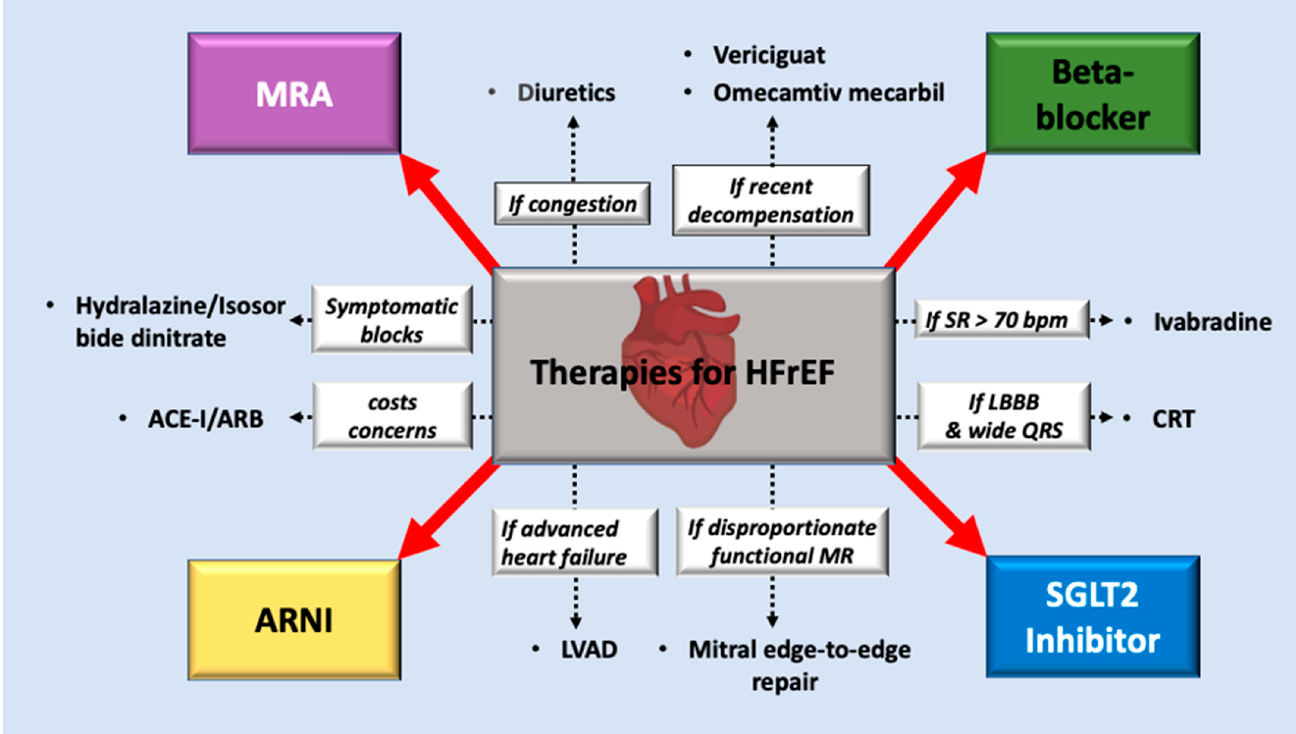
Figure 1. Pharmacological and interventional treatment for heart failure with reduced ejection fraction: The red arrows indicate a combination of the four drugs that should be initiated early in HFrEF patients. The dotted arrows indicate the additional drugs and interventional therapies for individualized treatment for specific populations. Table 1. Evidence of available pharmacological therapy of heart failure.